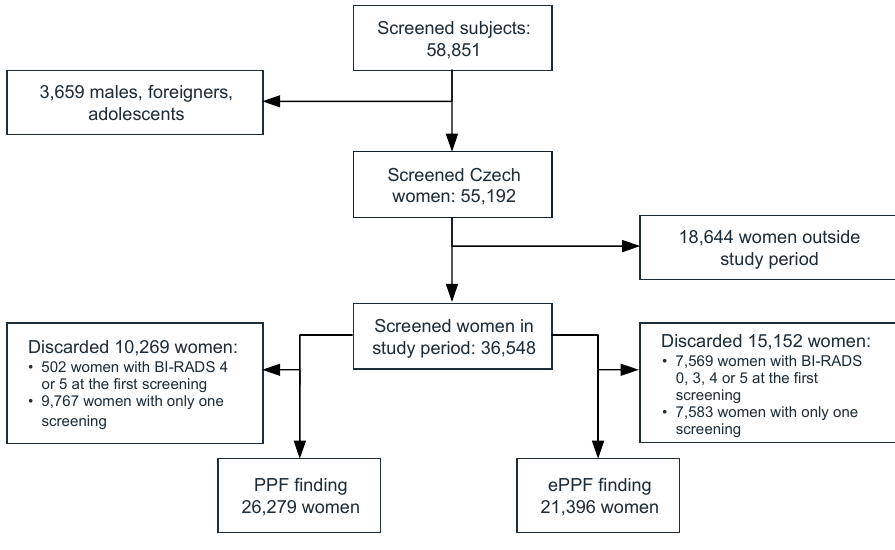
Figure 1. Study population flow.